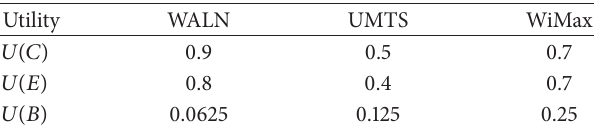
Table 9: Utility used for ping-pong effect